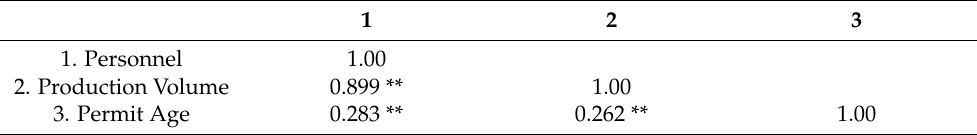
Table 3. Correlations Between Brewery Permit Age, Number of Personnel, and Production Volume.